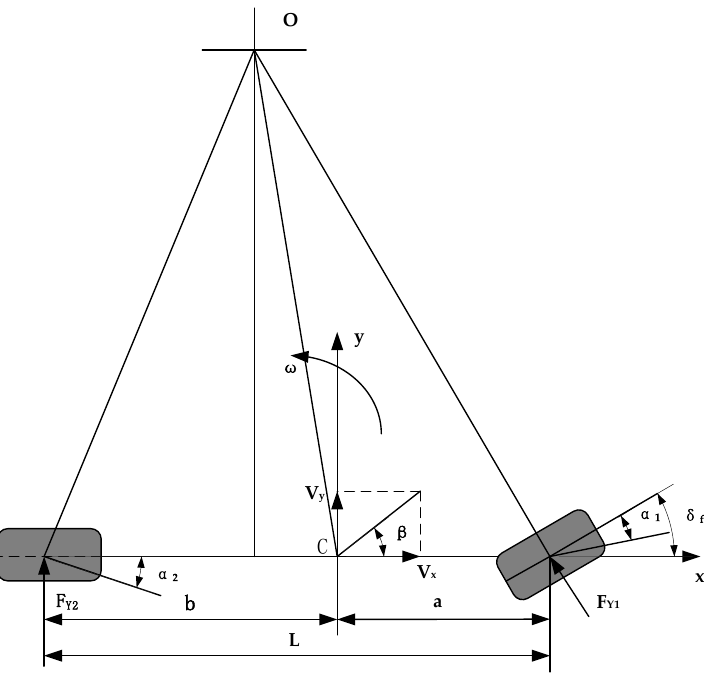
Figure 1 only considered the two degrees of freedom of lateral movement along the y-axis and yaw movement around the z-axis.